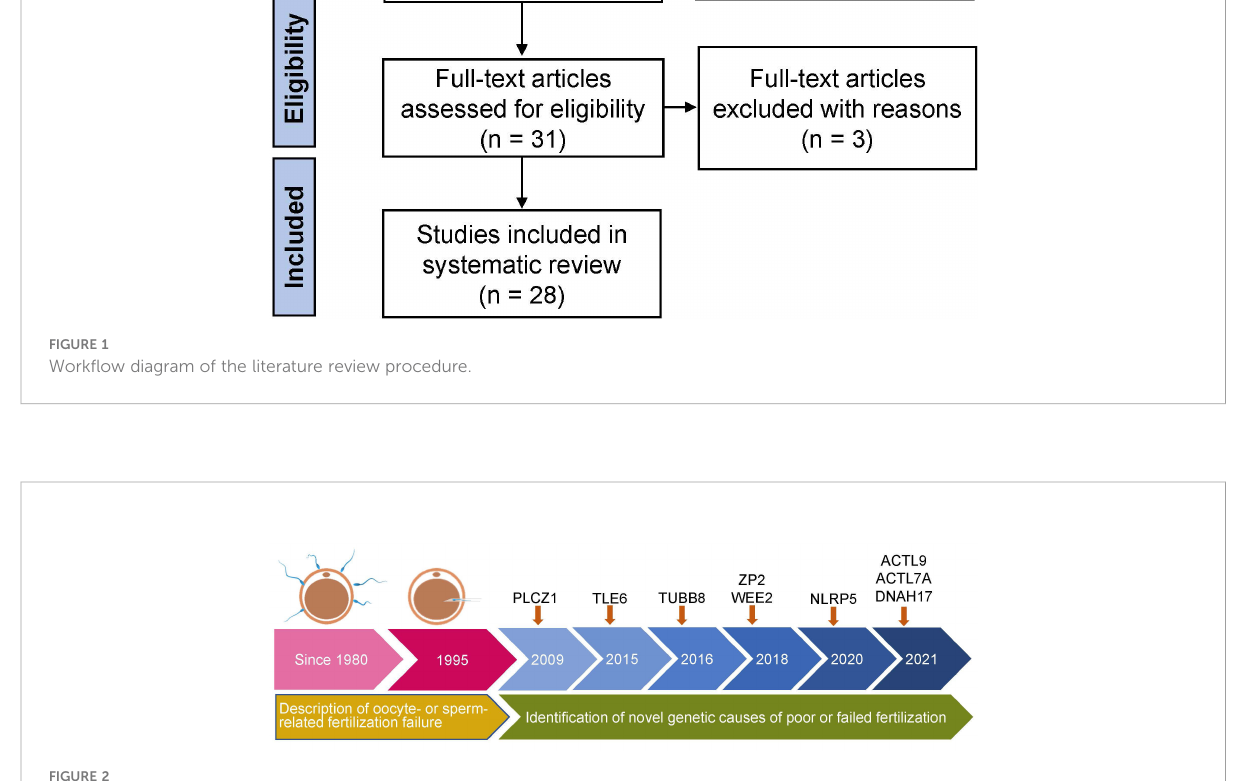
FIGURE 2 Timeline of discovery of mutations of genes that lead to poor and failed fertilization. PLCZ1, Phospholipase C zeta 1; WEE2, WEE1 Homolog 2; TUBB8, Tubulin beta 8 class VIII; NLRP5, NLR family pyrin domain containing 5; ACTL9, Actin-like 9; ACTL7A, Actin-like protein 7A; ZP2, Zona pellucida glycoprotein 2; TLE6, transducin-like enhancer of split 6; DNAH17, Dynein axonemal heavy chain